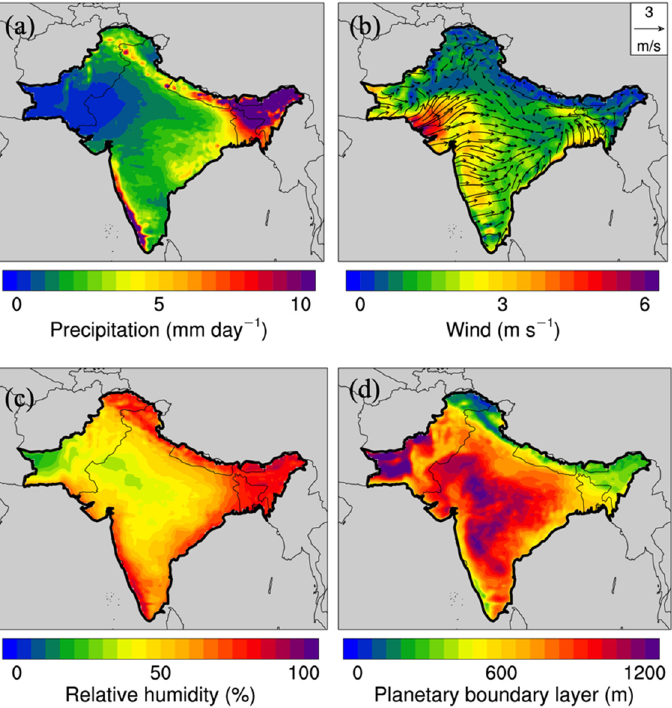
Figure 6. Climatology of meteorological conditions between 2005 and 2019. ( a ): precipitation (units: mm/day), ( b ): wind at 10 m (unites: m/s), ( c ): relative humidity (unites: %), and ( d ) planetary boundary layer height (unites: m). Data retrieved from ERA5 reanalysis.